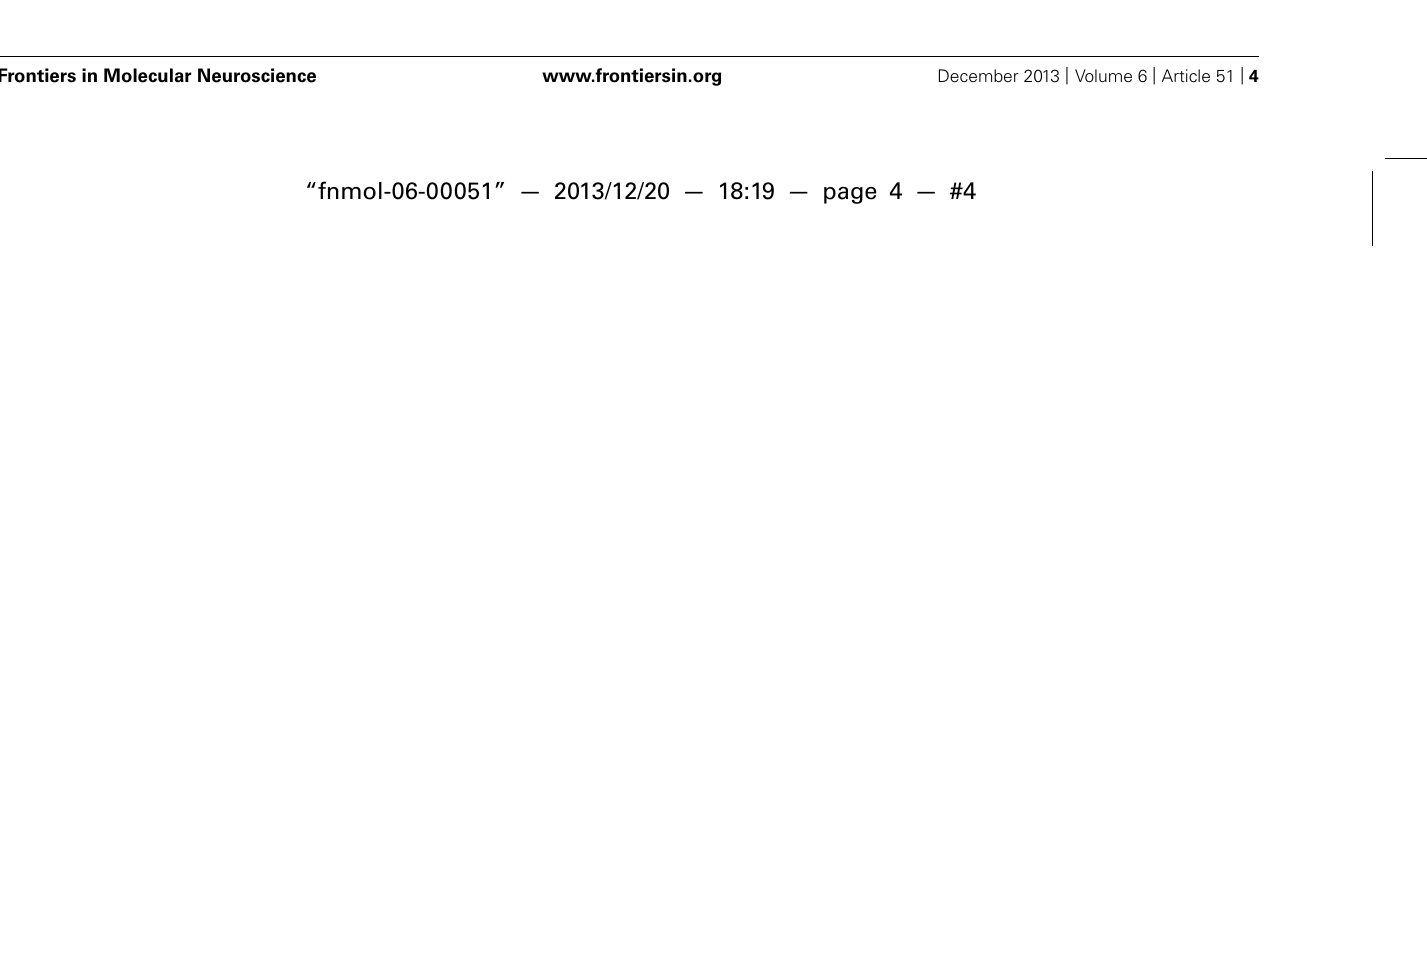
pluripotency factors Lin 24 and 28 by microRNA let-7 . (B) let-7 − / − neurons are still able to regenerate destroyed axons, since the pluripotency factors Lin 24 and 28 stay expressed even in post-mitotic